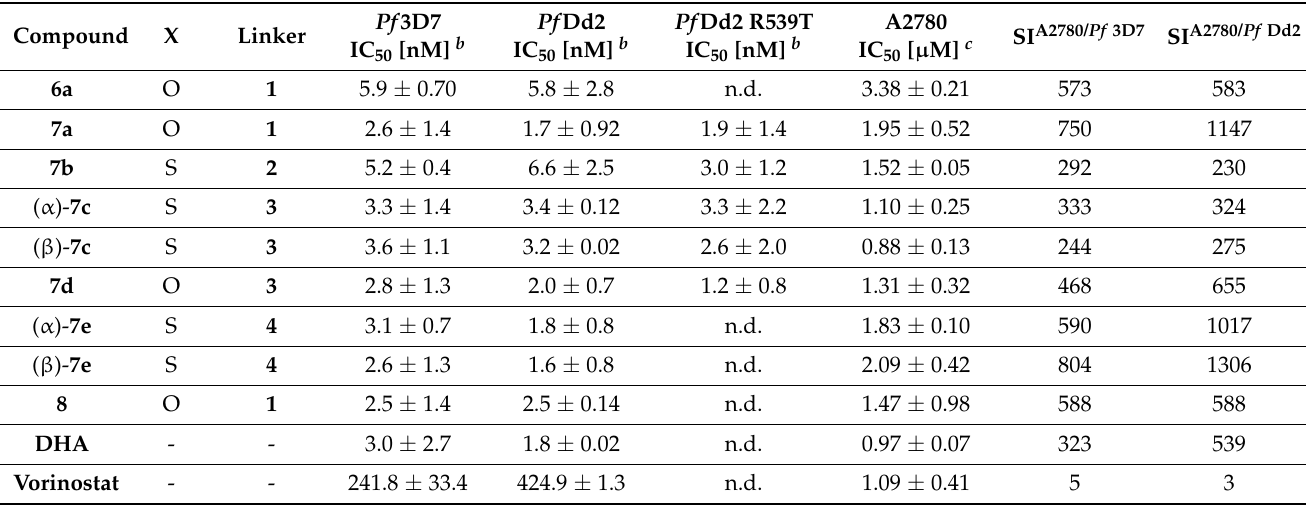
Table 2. In vitro activity against asexual blood stages of P. falciparum parasites, cytotoxicity, and selectivity indices of 6a , 7a–e , and 8 a